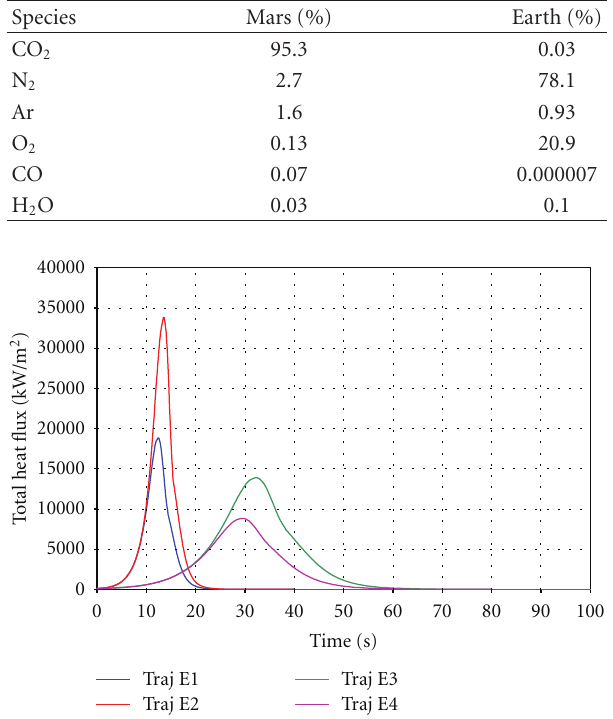
Table 1: Mars and Earth atmosphere compositions.